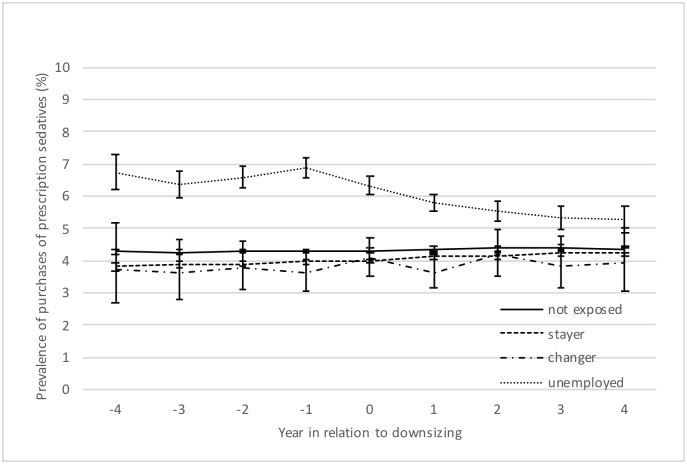
Prevalence of purchased prescribed sedatives by employment status (%).Adjusted for sociodemographic factors and previous sickness absence history, with 95% CI.